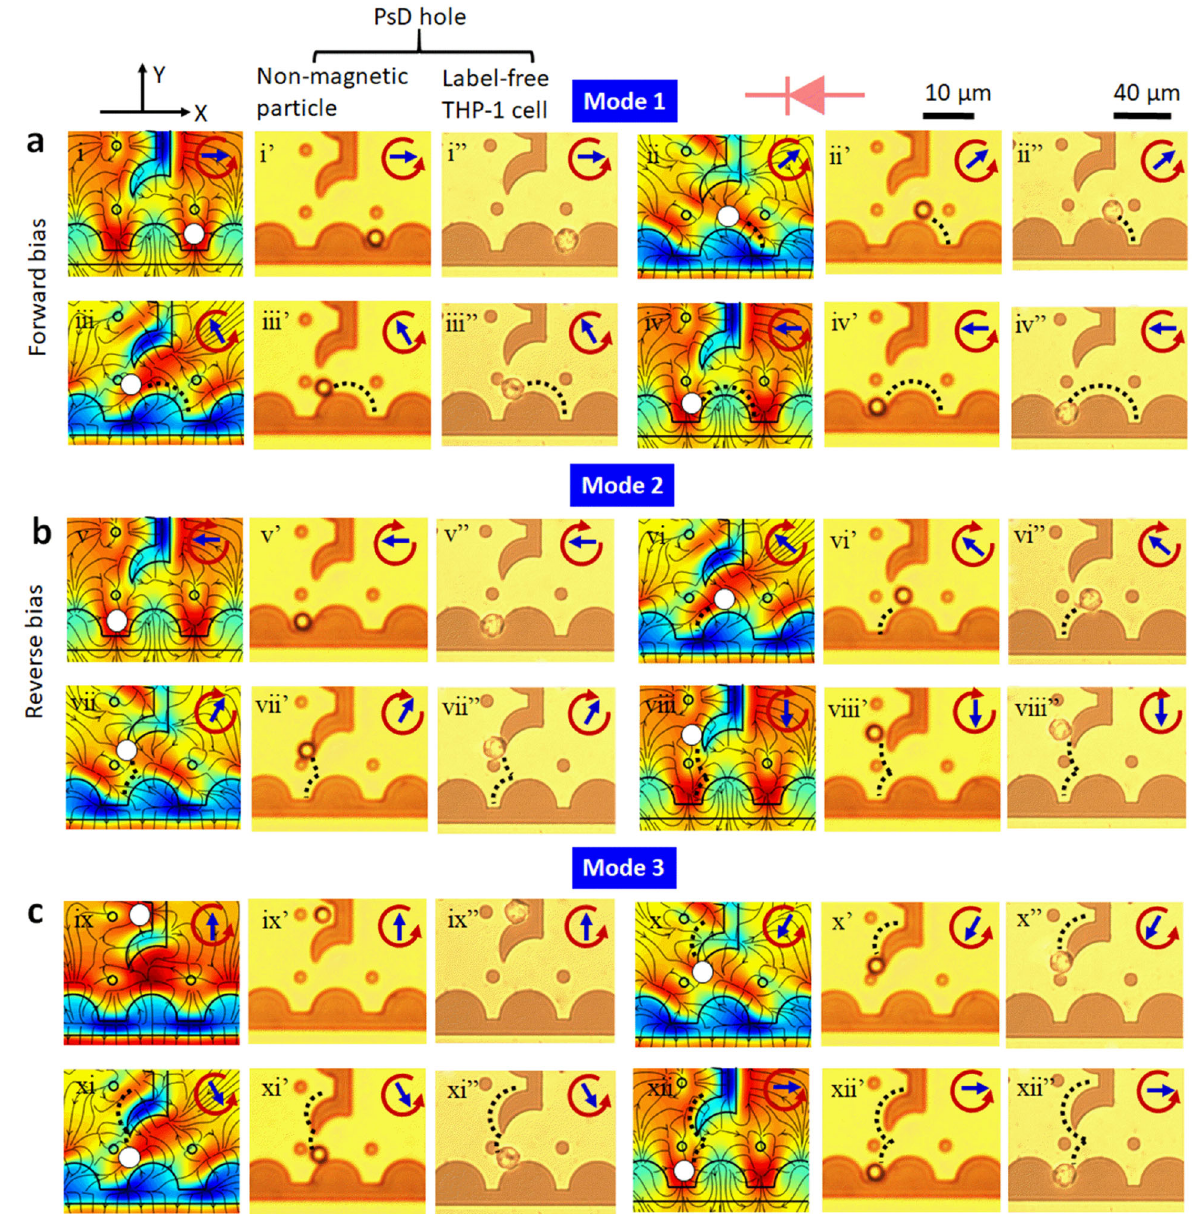
Fig. 5 Experimental and simulation results showing the traces of PsD holes and cells during magnetic fi eld rotations. Magnetic force lines and the fi eld potential energy maxima (red) landscapes ( fi rst column) correspond to traces of 3.57 µ m PsD holes in diameter (second column) and THP-1 cells (third column) over a negative micro-magnetic eclipse diode under three-moving modes. a Mode 1 in forward bias mode. Due to the merging of maximum potential energies, the PsD hole located at the right side of the eclipse junction switches the junction gap d = 7 µ m during counterclockwise fi eld rotation at angles ɵ = 180°, 240°, 300°, and 360°. Blue arrows represent the direction of the magnetic fi eld. The black dotted lines denote the PsD hole/label-free cell trajectories on the eclipse diode. b Mode 2 in reverse bias mode. The PsD holes/label-free cells located on the left side of the eclipse junction cannot switch the eclipse junction, thereby navigating towards the Y -axis due to the potential energy split under clockwise fi eld rotation at angles of ɵ = 360°, 300°, 240°, and 180°. c Mode 3, the PsD holes/label-free cells jump from the positive Y -axis to the negative X -axis at an eclipse junction during counterclockwise fi eld rotation at angles of ɵ = 90°, 240°, 300°, and